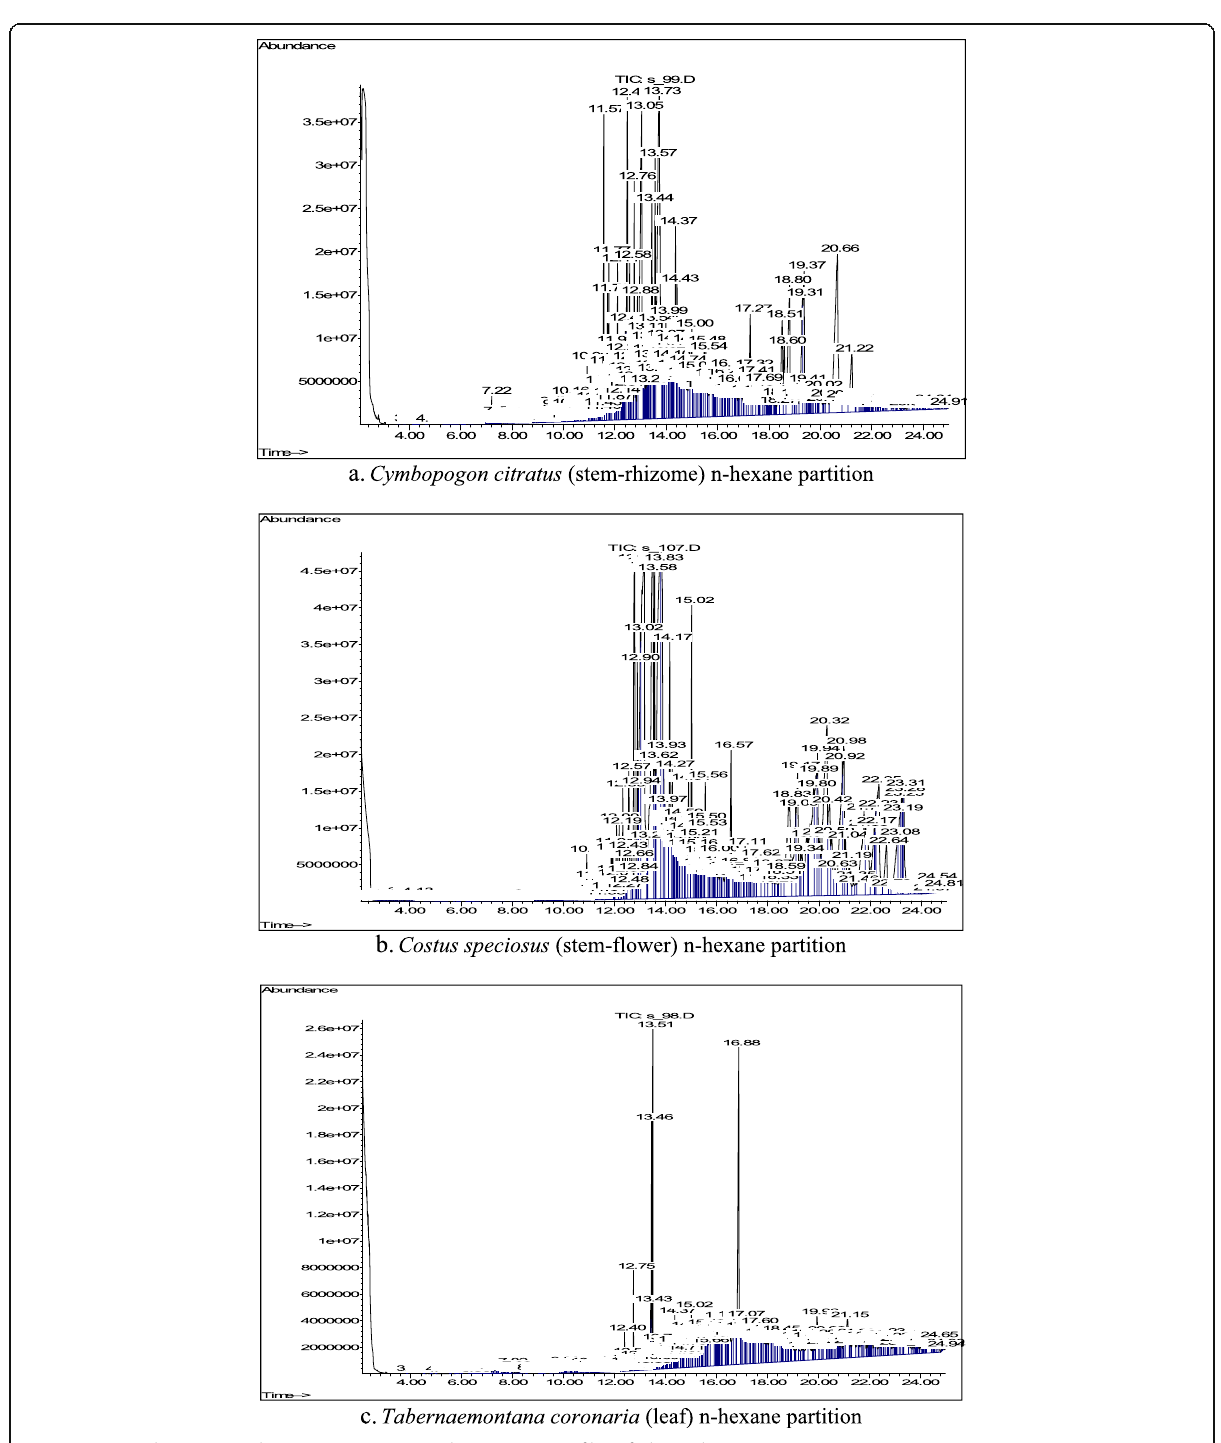
Fig. 1 a - c Gas chromatography-mass spectrometry chemometric profiles of plant n-hexane